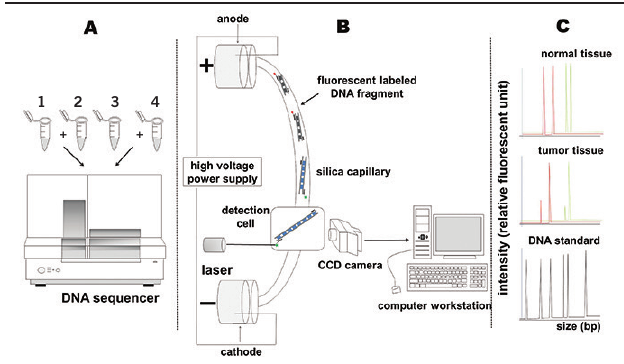
figurE 3 − Reading of LOH screening by capillary electrophoresis in automated DNA sequencer LOH: loss of heterozygosity; DNA: deoxyribonucleic acid; PCR: polymerase chain reaction; CCD: charge-coupled device. A) After microsatellite amplification, internal-lane size standard (1 and 3), PCR products from normal DNA (2) and tumor DNA (4) are subjected to capillary electrophoresis on